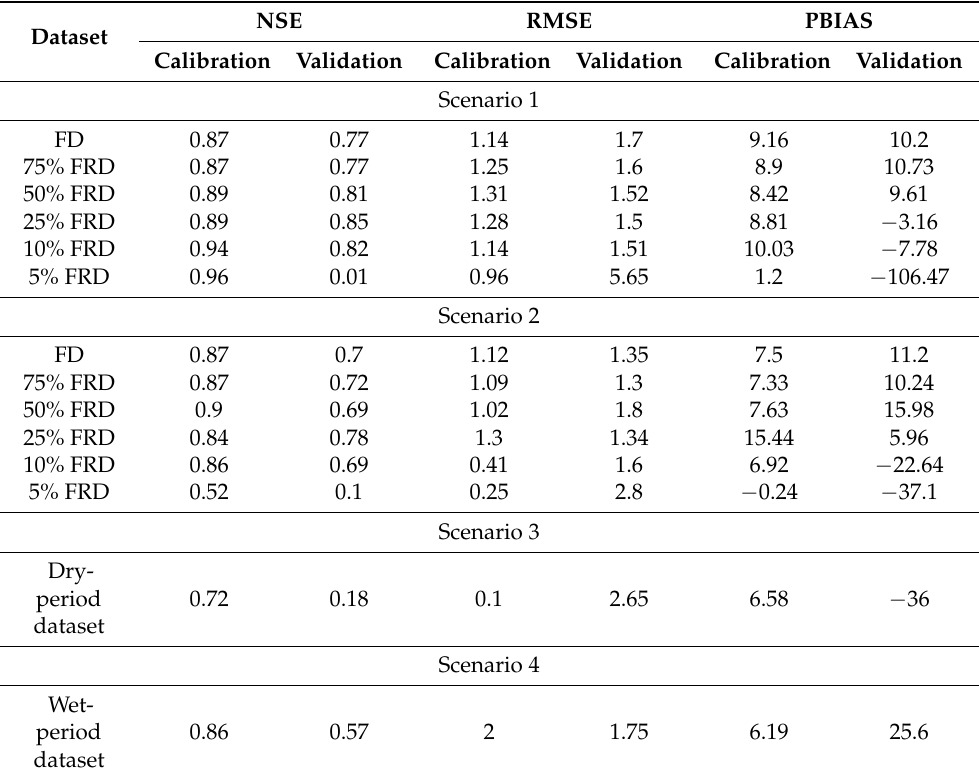
Table 5. Results of performance measures for the four